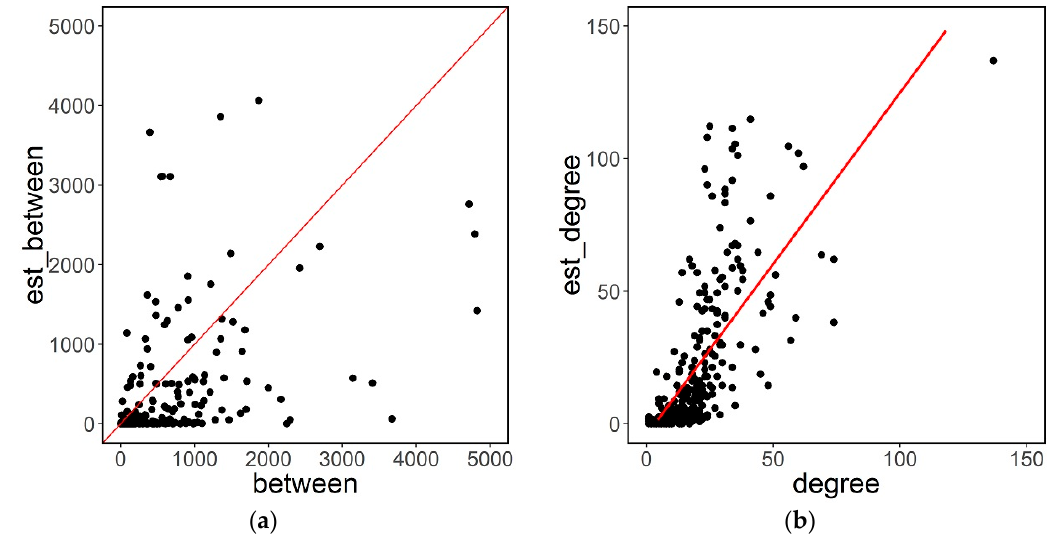
Figure 4. Relationship between estimates of ( a ) betweenness, ( b ) nodes degree, and its reciprocal real values for Faculty 16.